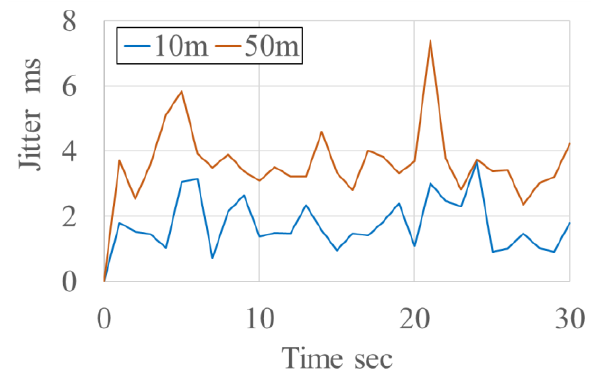
Figure 21. Temporal evolution of UDP jitter in each communication distance (the sender is controller): The blue line is the 10 m results, and the orange line is the 50 m